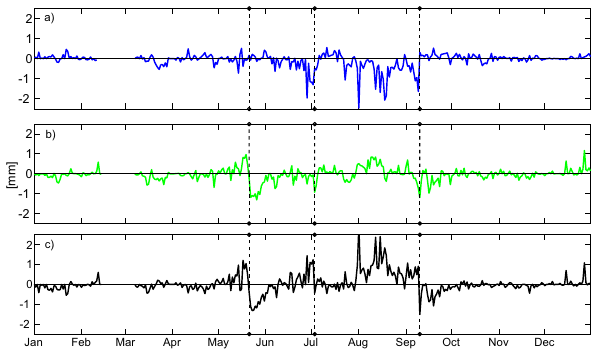
Figure 10. Differences between daily ET for 2012. Displayed are ET a -EC–ET PM (a) , ET a -LYS–ET PM (b) , and ET a -LYS–ET a - EC (c) . The dashed lines indicate harvest at lysimeters.